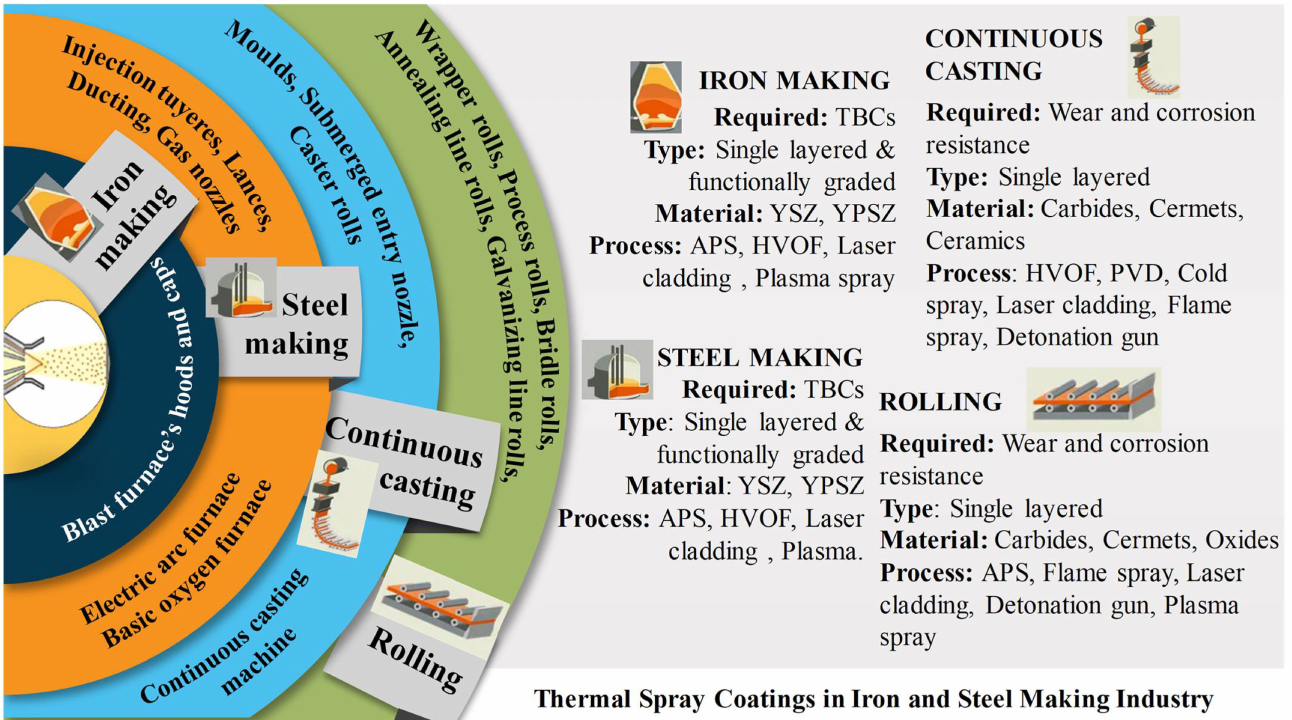
Figure 15. Demonstration of use of thermal spray coatings for various components of iron and steel making industry. APS = atmospheric plasma spray, HVOF = high velocity oxygen fuel, PVD = physi- cal vapor deposition, YSZ = Yttria stabilized zirconia, YPSZ = Yttria partially stabilized